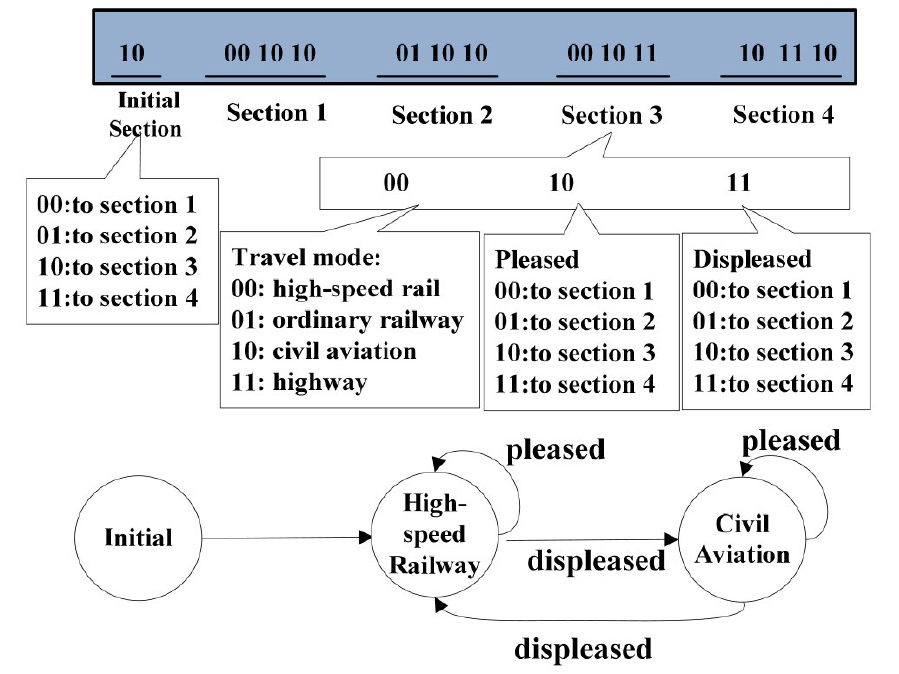
Figure 1. Act Decision-making Chain of Business